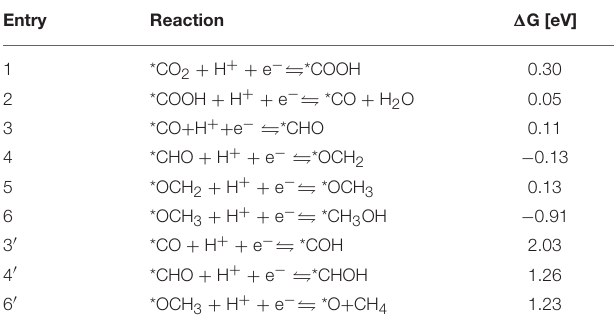
TABLE 2 | The 1 G of CO 2 to CO, methane and methanol at U = 0V vs. the reversible hydrogen electrode (RHE) as determined by Yao et al.